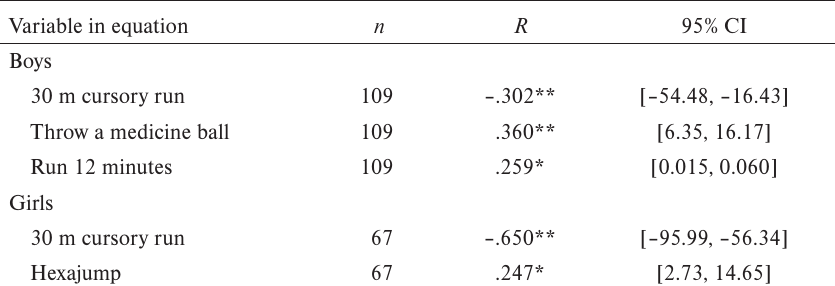
Entry tests predicting performance in the athletic polyathlon Variable in